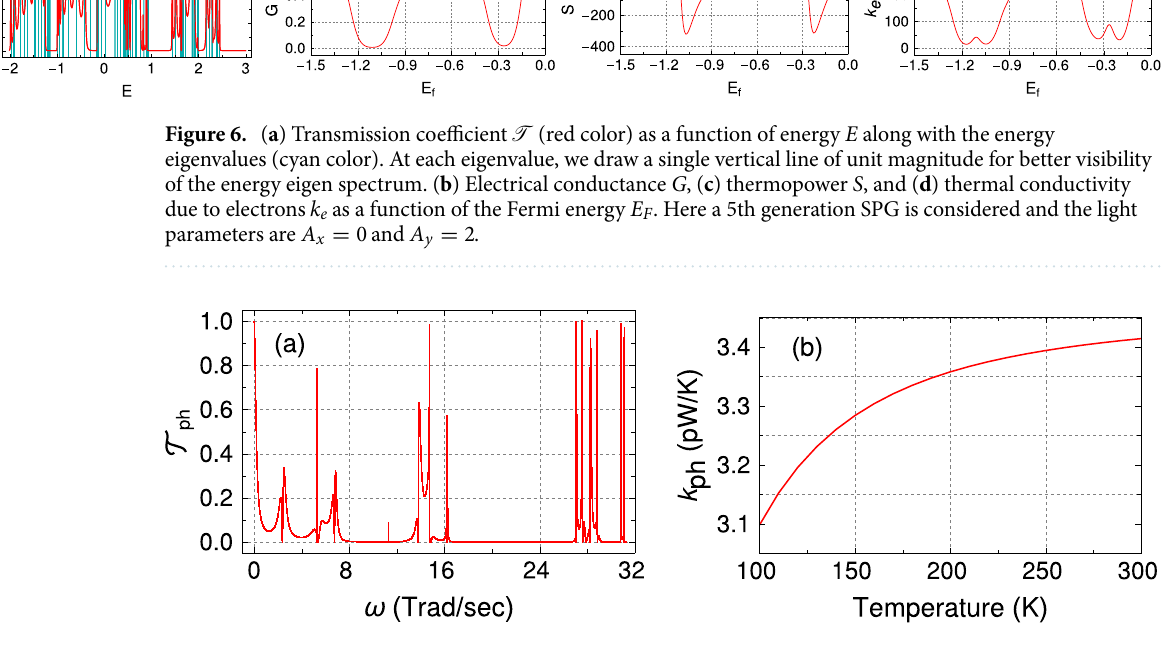
Figure 7. ( a ) Phonon transmission T ph as a function of phonon angular frequency ω . ( b ) Phonon thermal conductance k ph as a function of temperature T